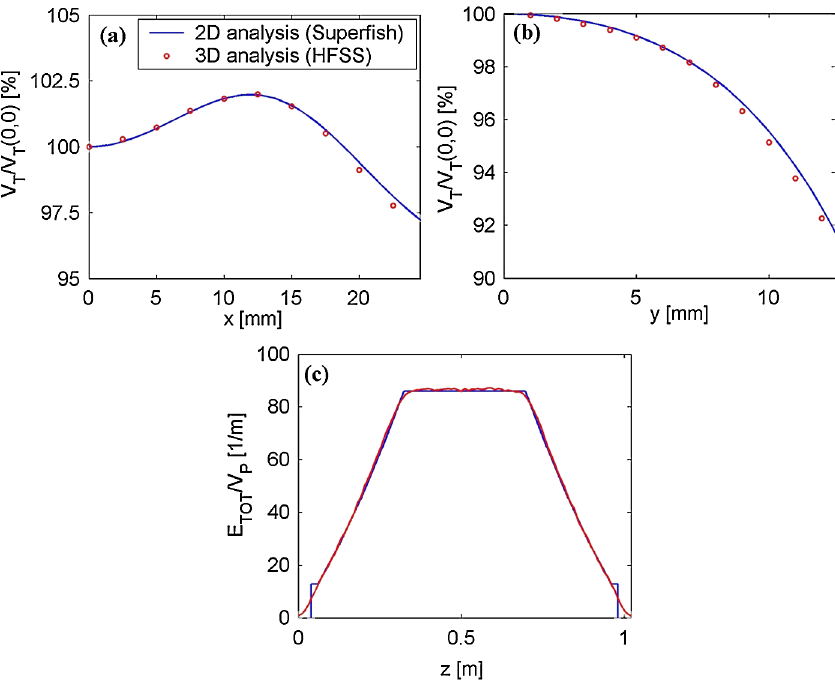
FIG. 7. Integrated deflecting field as a function of the horizontal (a) and vertical (b) coordinates. (c) Deflecting field in the center of the structure as a function of the longitudinal coordinate.